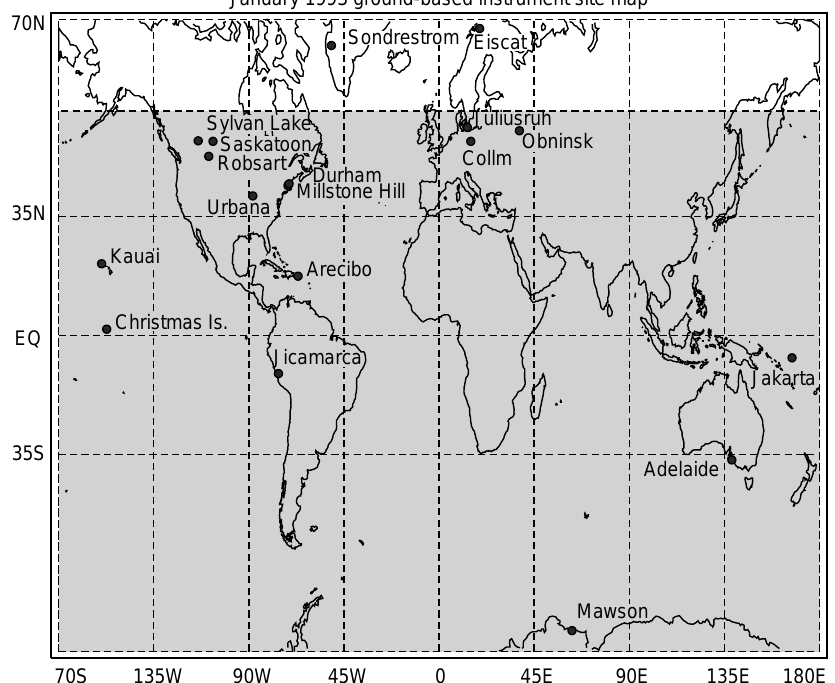
Fig. 1. A map indicating the geographic location of the ground-based instruments which provided data for this study. The shaded region indicates the nominal latitude range where UARS HRDI and WINDII data